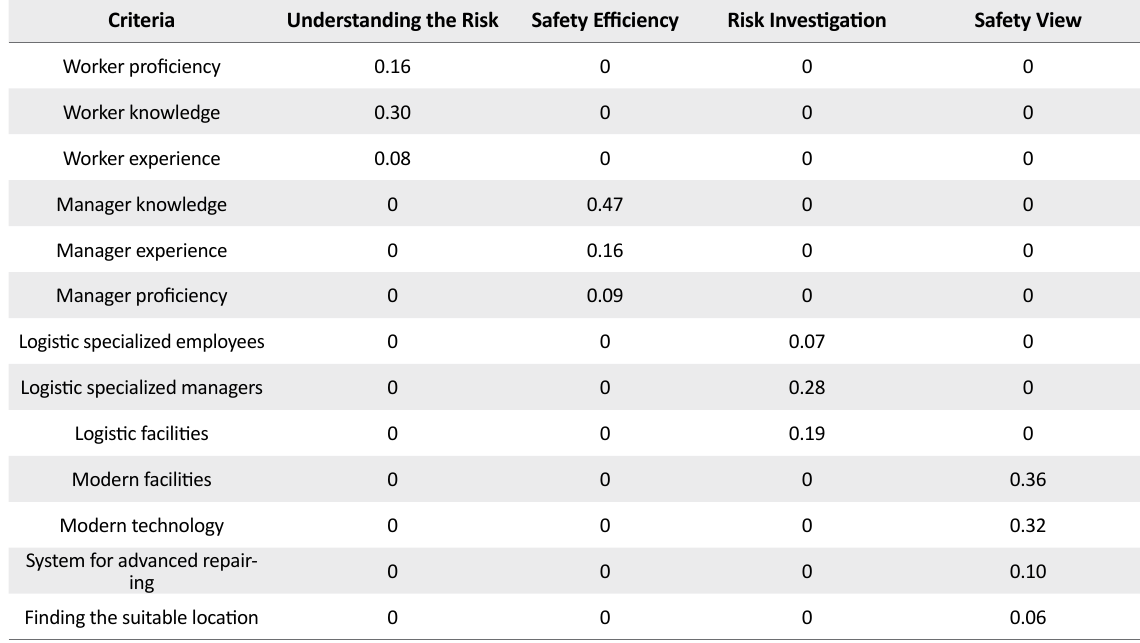
Table 3. The combined correlation (binary) of the sub-criteria of the health risk Criteria Understanding the Risk Safety Efficiency